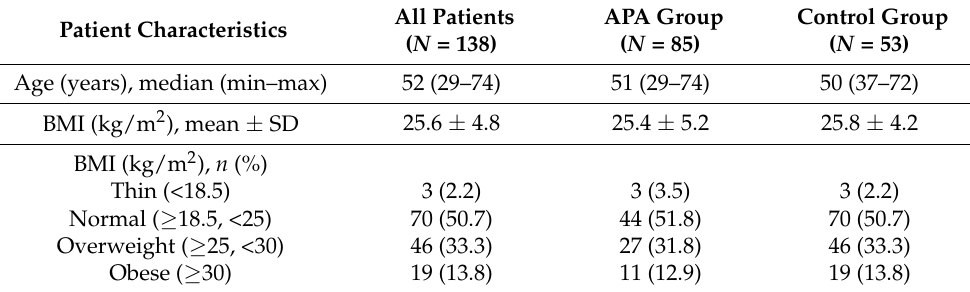
Table 1. Patient characteristics at baseline ( N =